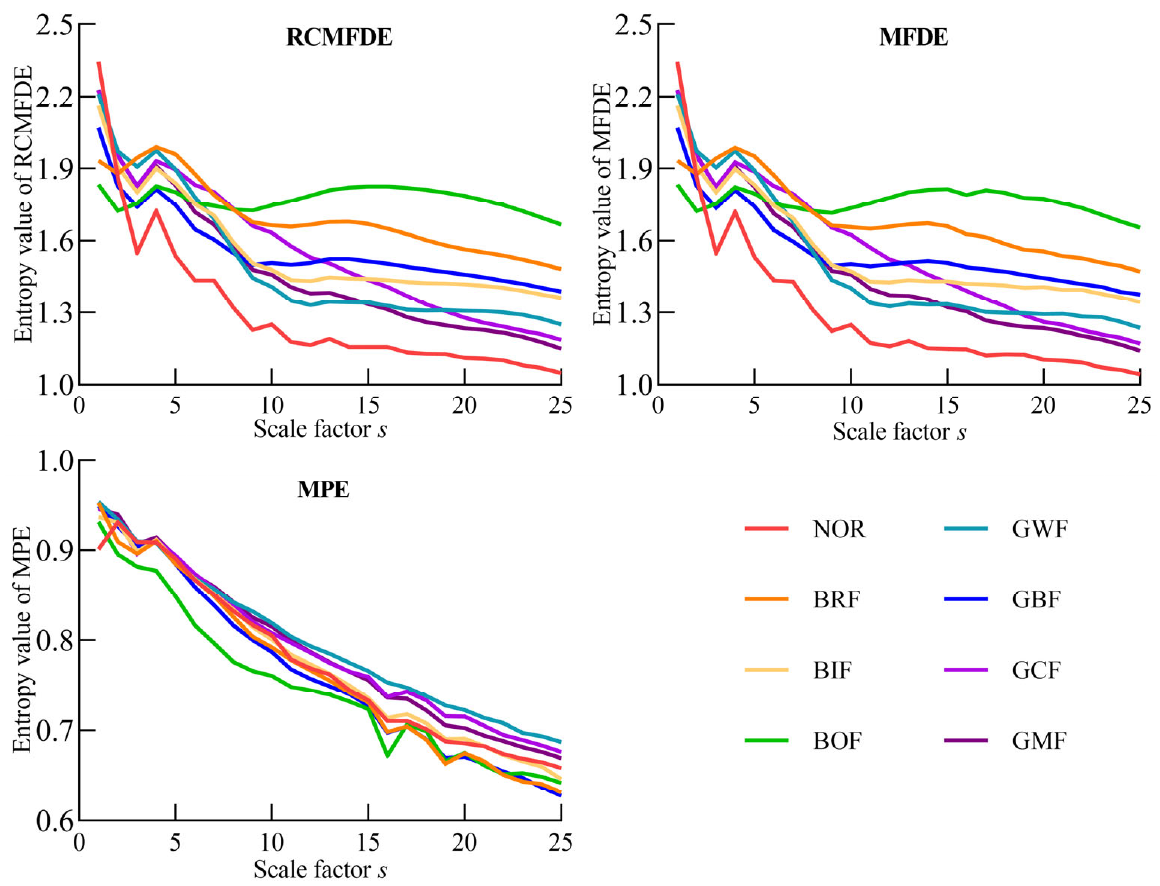
Figure 11. Feature extraction results of three methods.